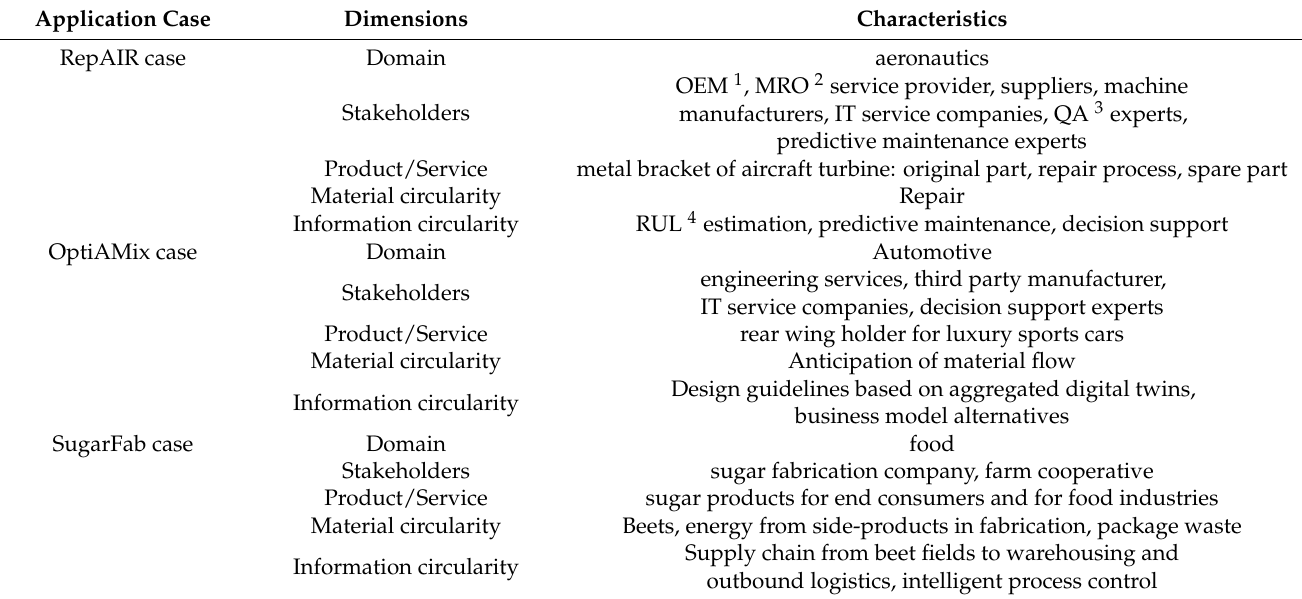
Table 2. Application case